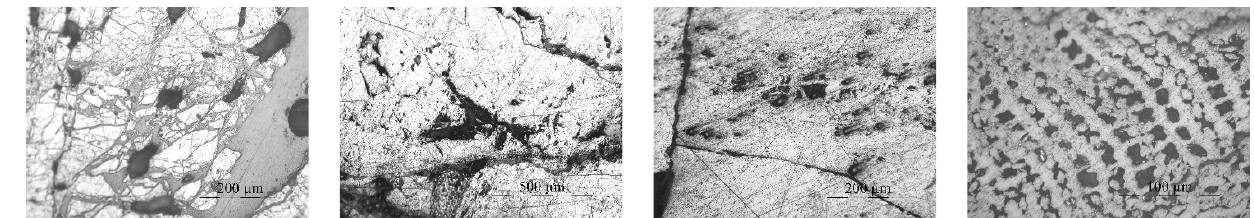
Figure 2. Microscopic pore and fracture features of coal samples.